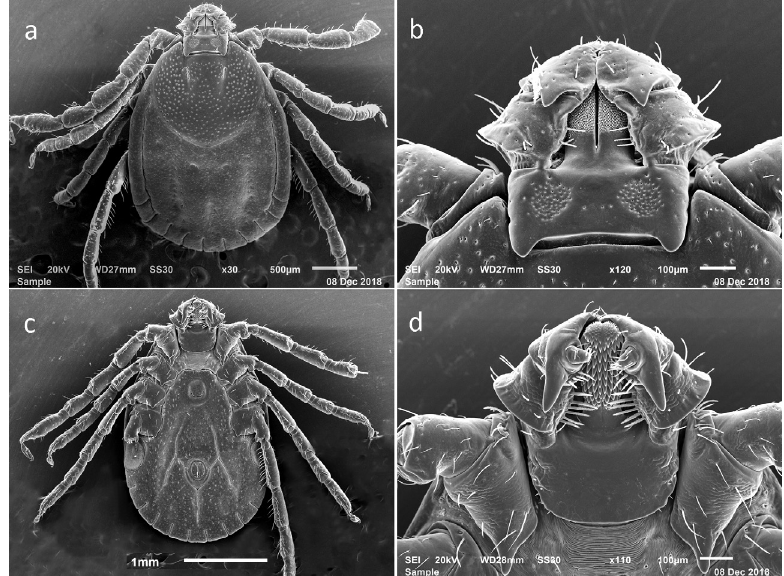
Figure 1. SEM photos of female H. longicornis from a colony started with specimens from Jeju-teukbye- oljachido, Republic of Korea (Accession # RML48803) a dorsal full body b dorsal capitulum c ventral full body d ventral